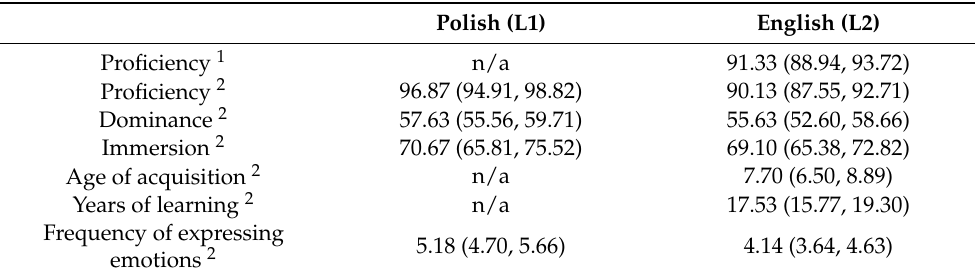
Table 1. Participants’ sociolinguistic data (means with 95%